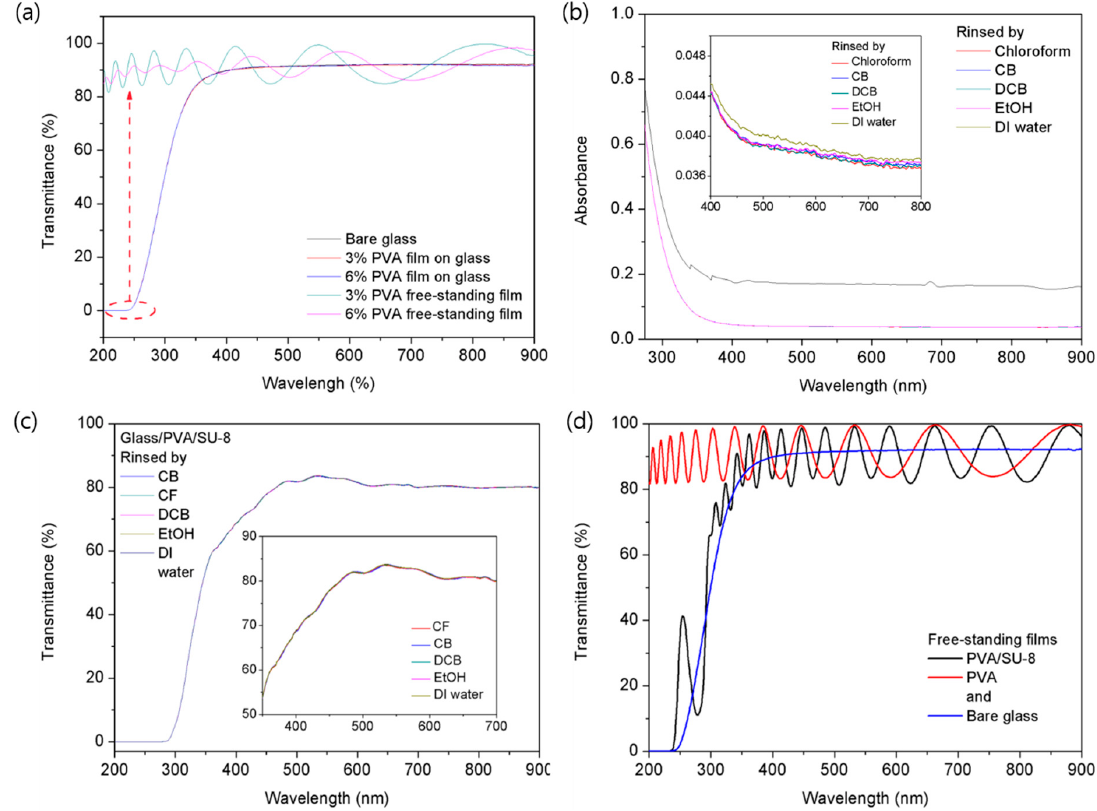
Figure 3. ( a ) Transmittance of bare glass, PVA / glass and PVA free-standing film, solvent resistance test of ( b ) PVA film and ( c ) PVA / SU-8 film, and ( d ) transmittance of various free-standing films and bare